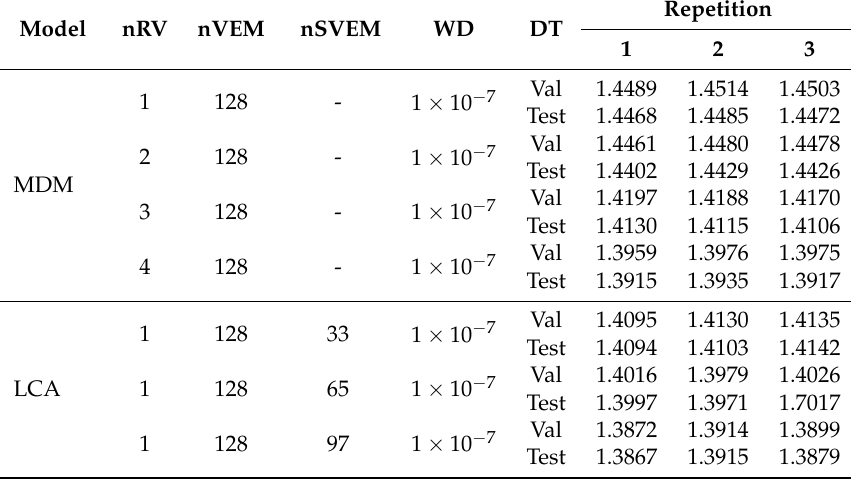
Table A2. Each BPC sample of evaluation results on the enwik8 LM task (nRV, number of read vectors; nVEM, number of vectors in the external memory; nSVEM, number of selected vectors in the external memory; WD, weight decay; DT, data type; MDM, MDM-NTM; LCA,